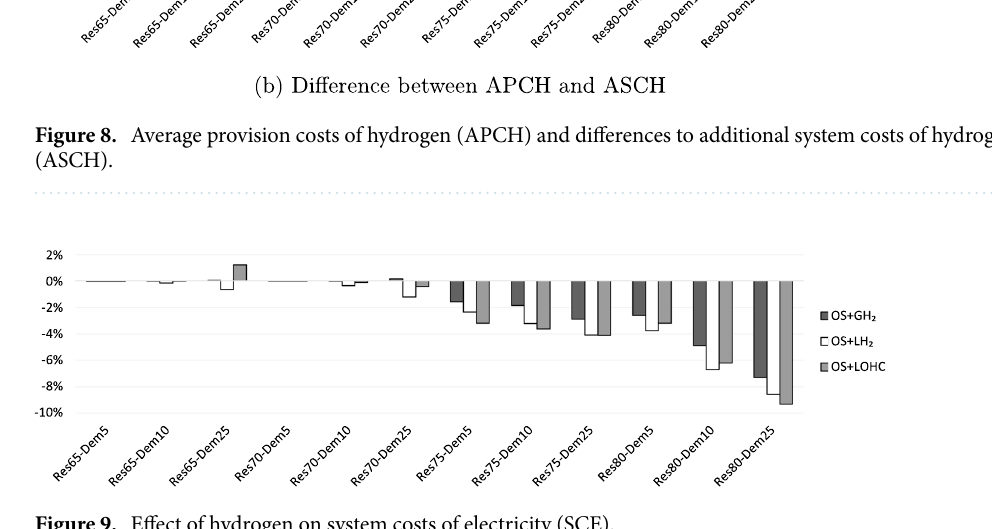
Figure 9. Effect of hydrogen on system costs of electricity